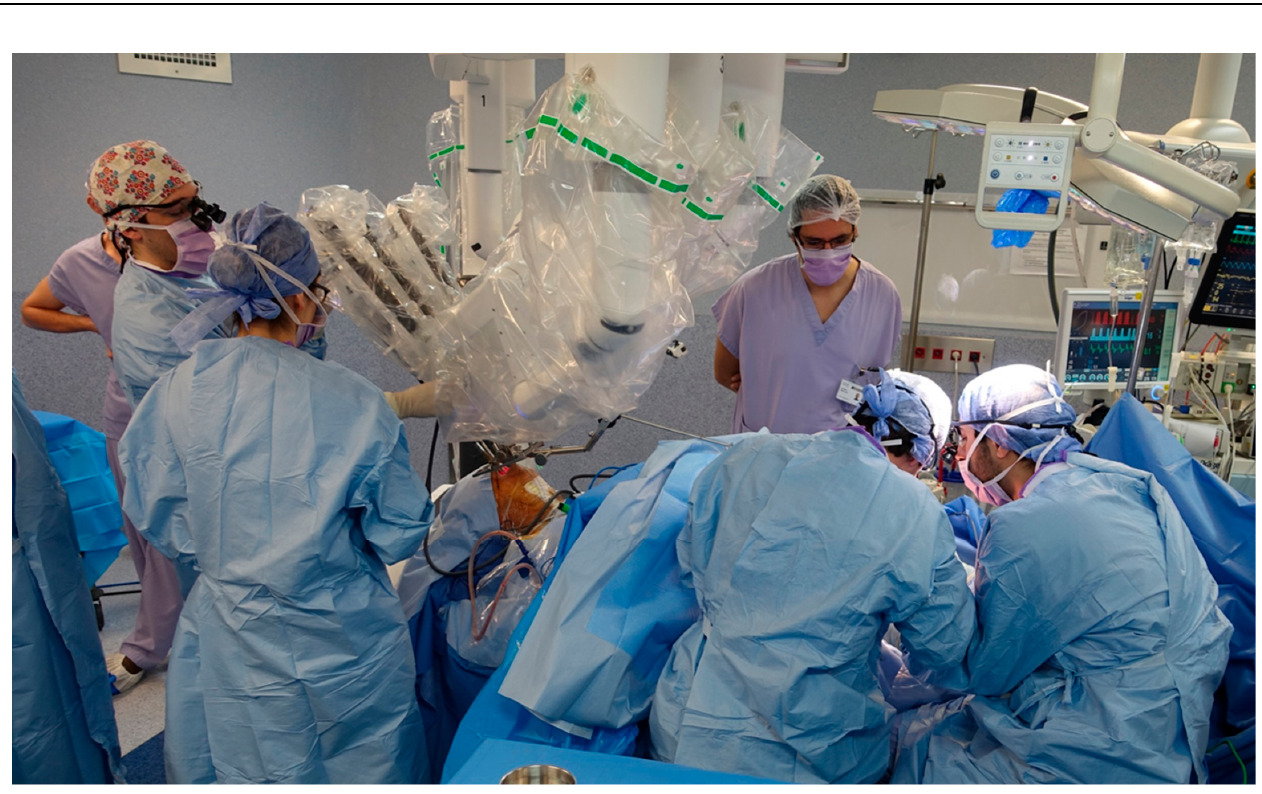
Figure 1. Situational image of the surgical room for two-team concurrent work in transoral robotic surgery and free flap reconstruction: the head and neck surgeon has performed a neck approach for vascular dissection and is installing the da Vinci ® Xi surgical system for transoral resection of the tongue base tumor while at the same time the reconstructive surgeons are harvesting a thin anterolateral thigh flap.